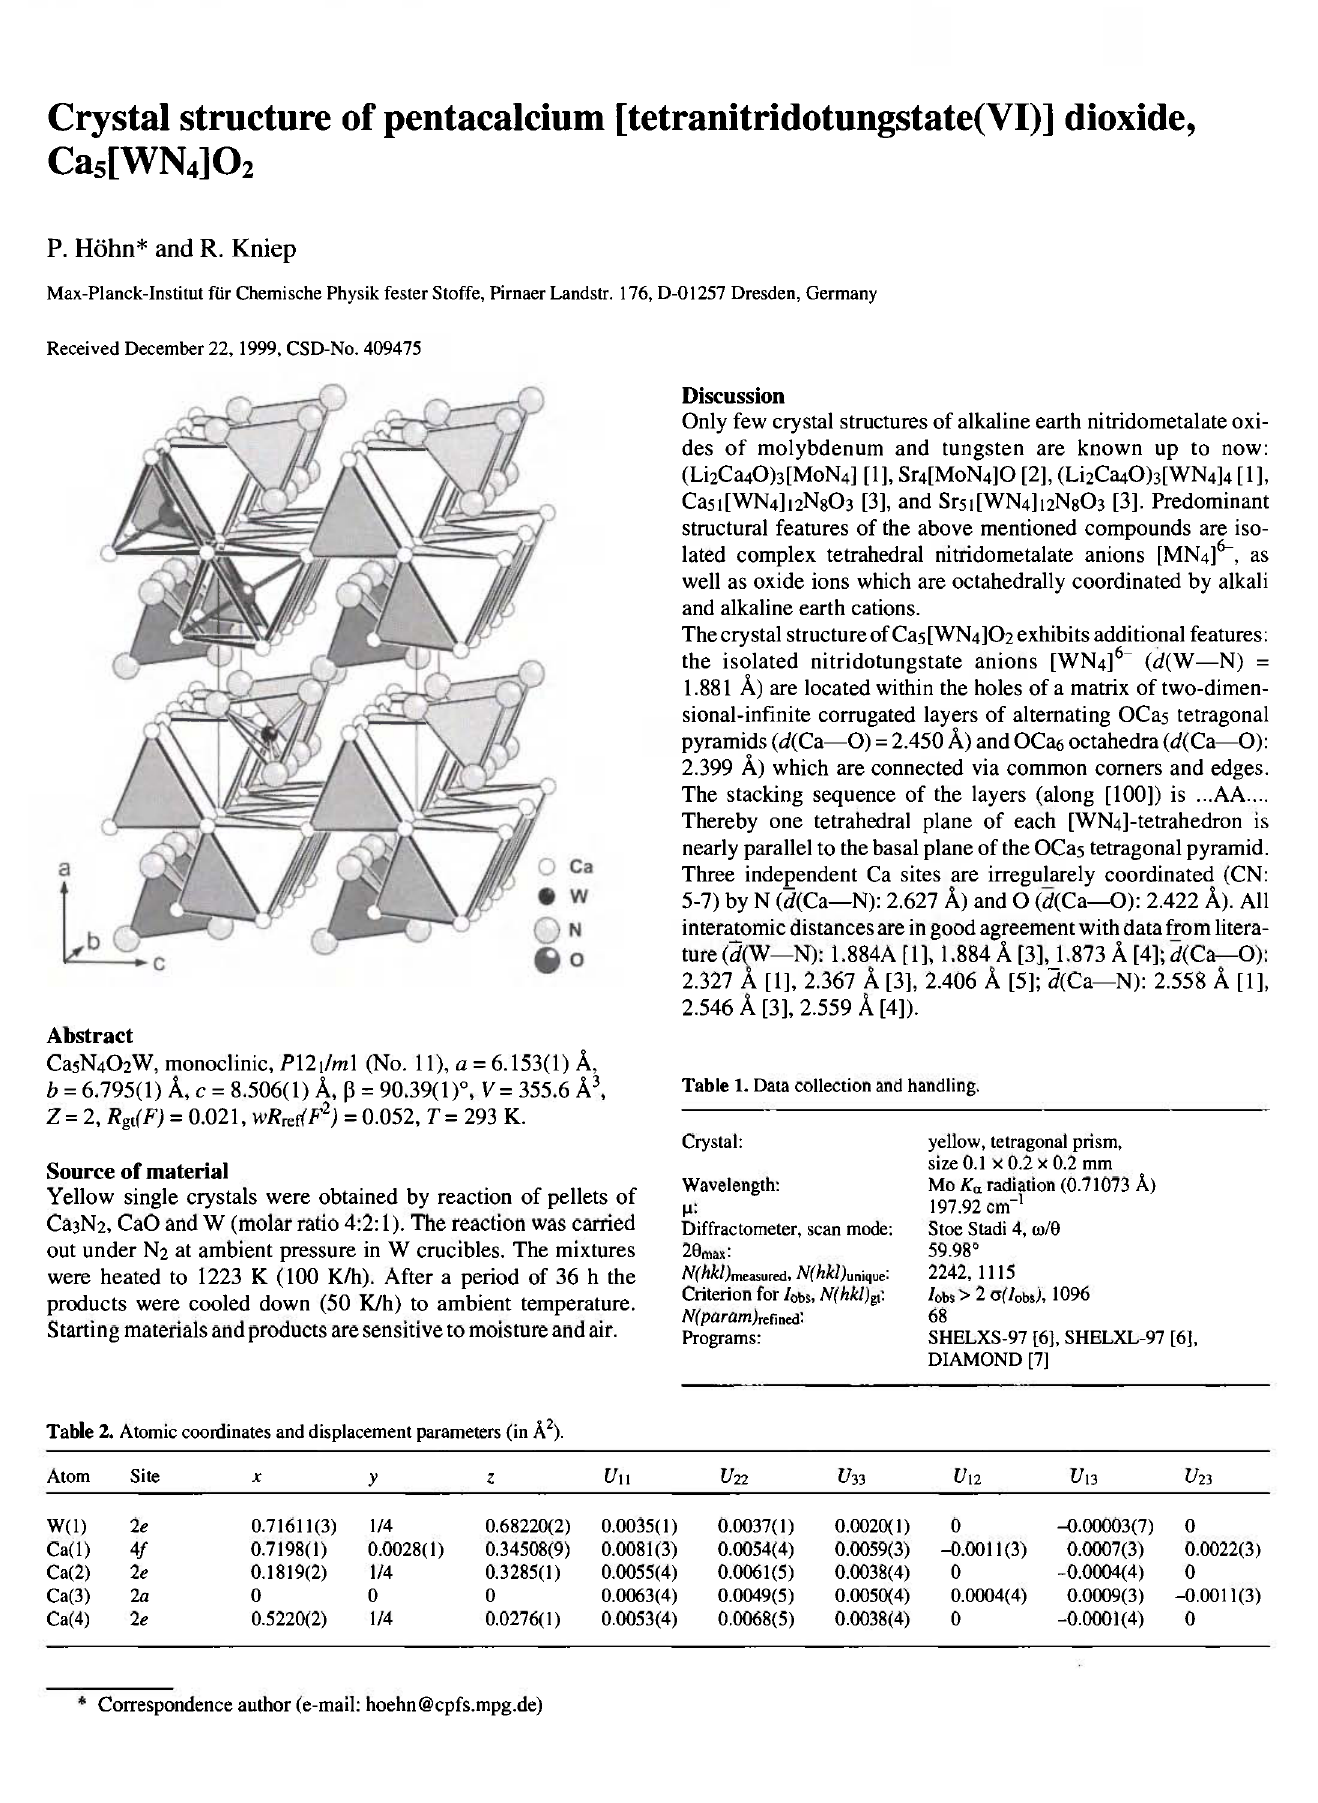
Table 2. Atomic coordinates and displacement parameters (in Ä 2